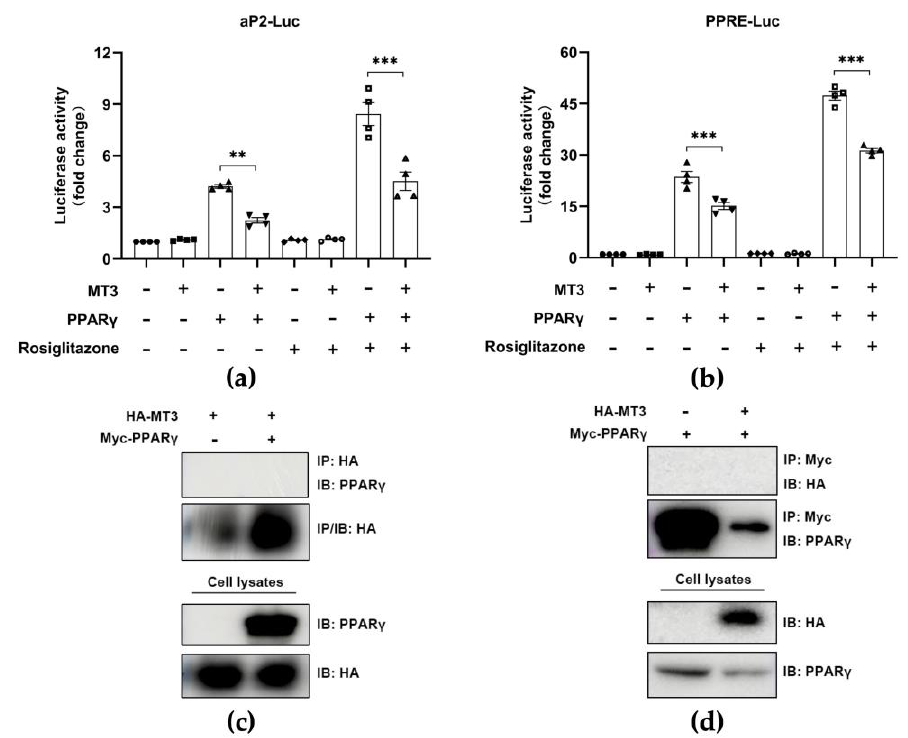
Figure 6. MT3 indirectly suppresses PPAR γ transcriptional activities. ( a , b ) HEK 293T cells were transfected with indicated HA − MT3 (0.5 µ g) or combinations of HA − PPAR γ (0.125 µ g) and transfected with indicated HA − MT3 (0.5 μ g) or combinations of HA − PPAR γ (0.125 μ g) and HA- MT3 (0.5 μ g) along with aP2 − Luc or PPRE-Luc reporter. pCMV − β − gal (0.025 μ g) was used to nor-